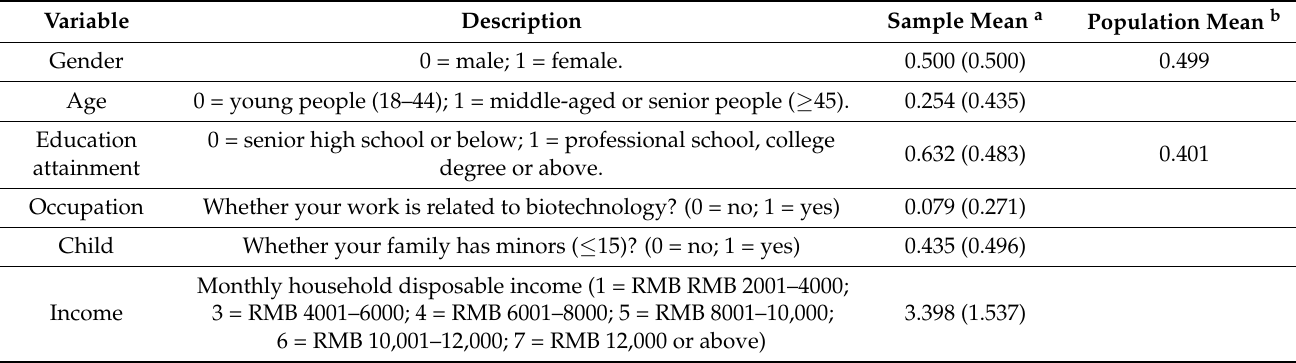
Table 2. Definition and descriptive statistics of the demographic variables.